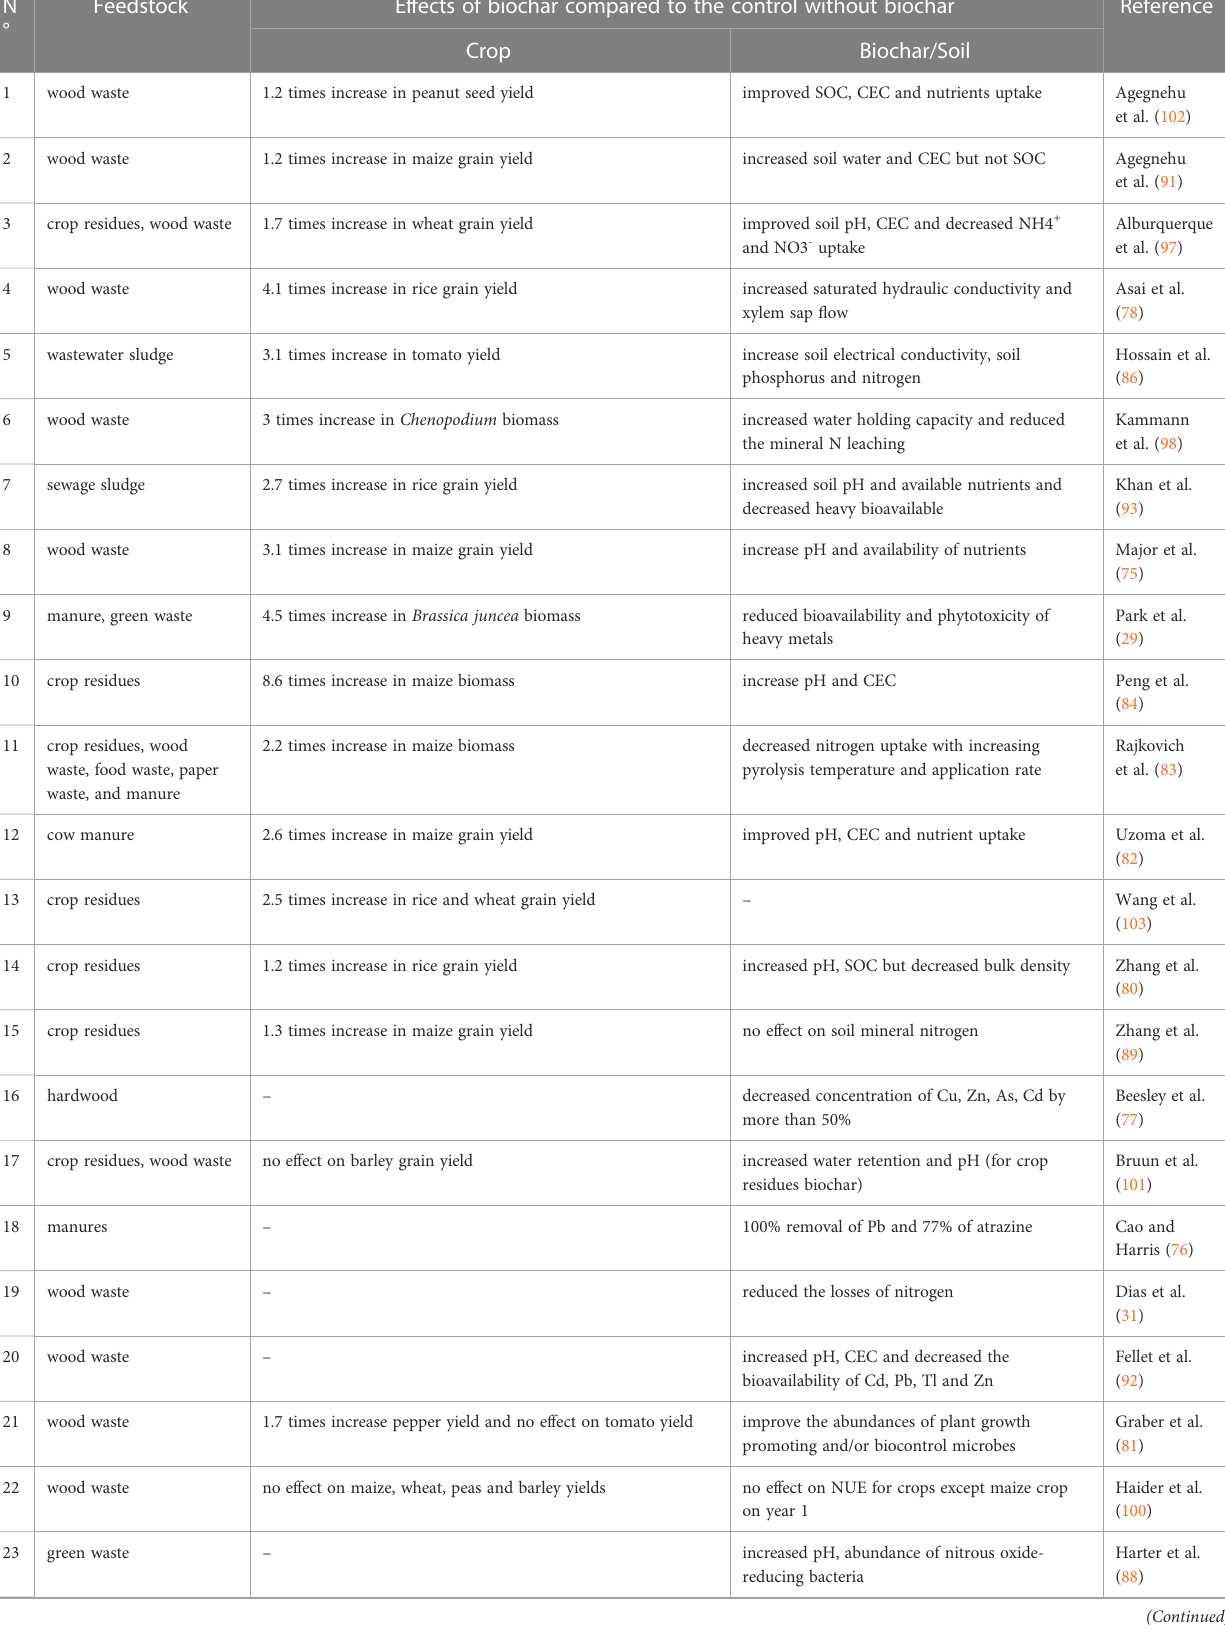
TABLE 6 Biochar feedstocks and their effects on crop and